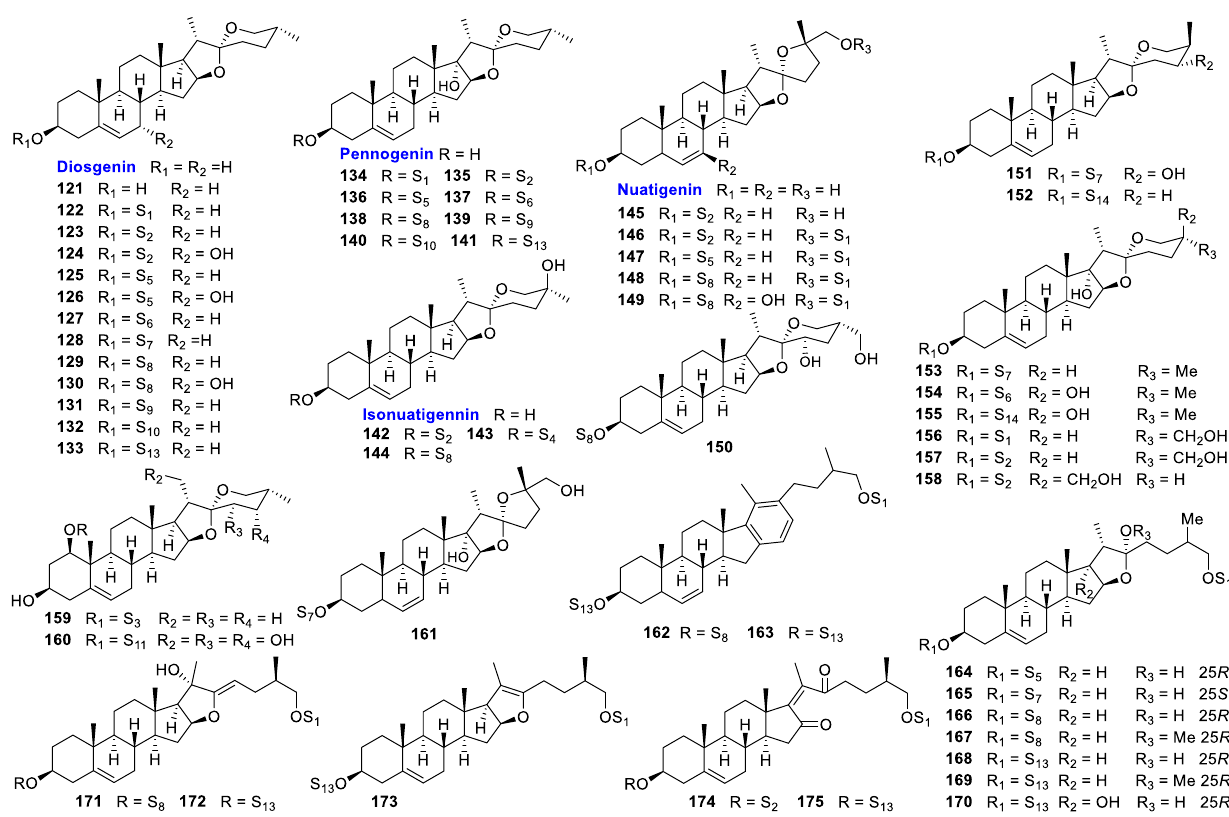
Fig. 5 Known steroidal sapogenins and